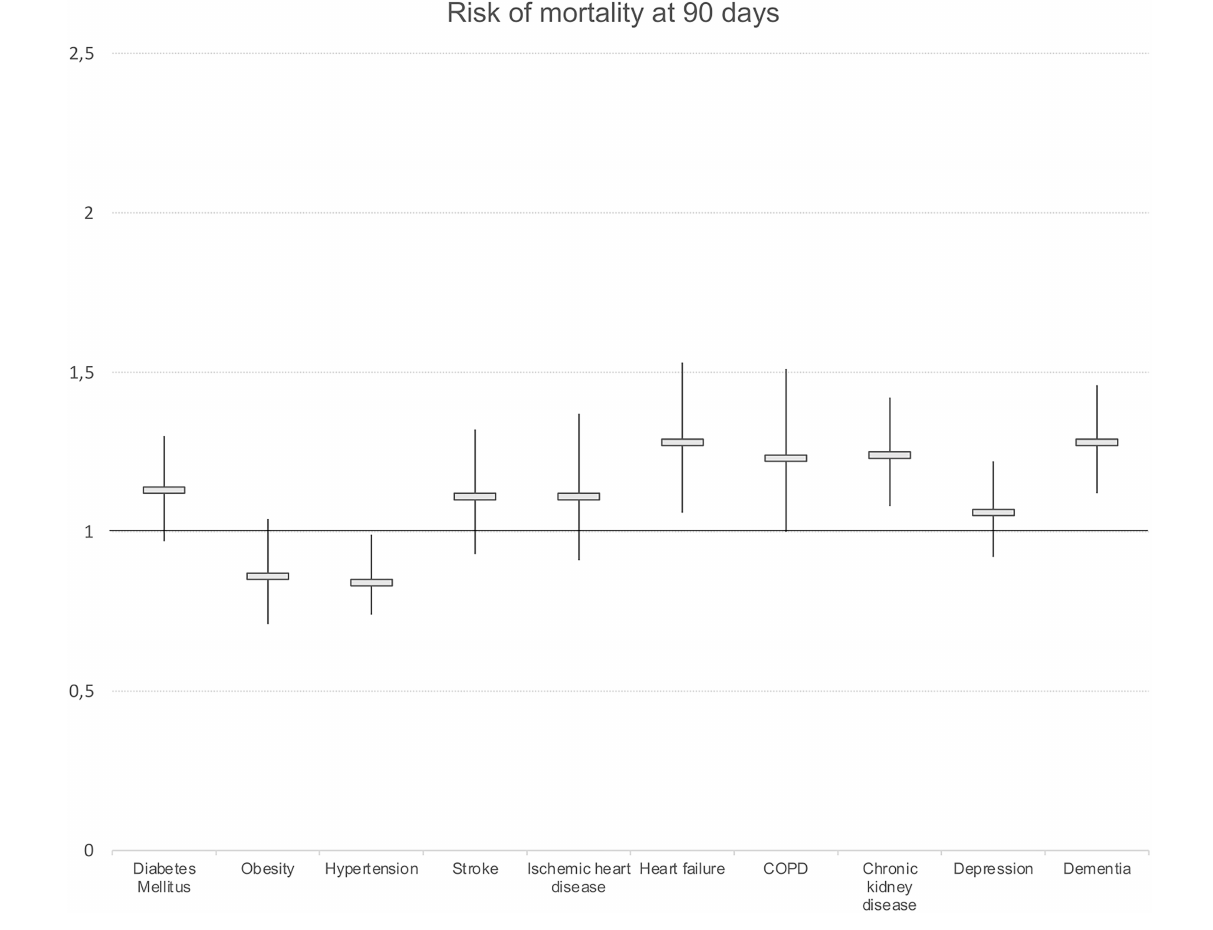
FIGURE 3 | Presence of chronic morbidity and risk of mortality at 90 days. Logistic regression models. Odds ratios and 95%Confidence intervals. Results adjusted by sex, age and socioeconomic level. COPD, chronic obstructive pulmonary